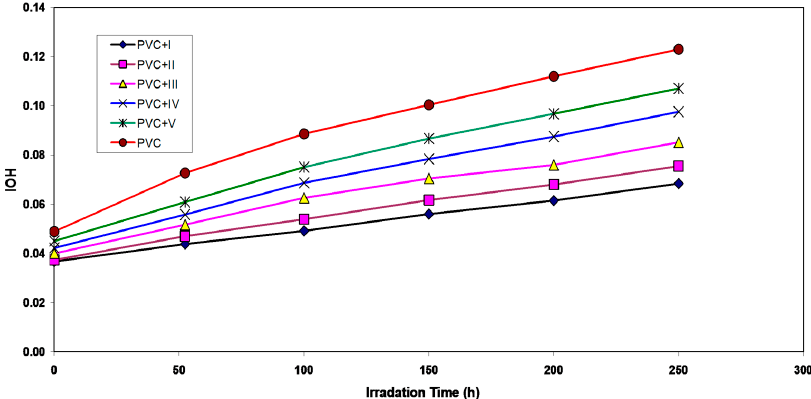
Figure 4. The relationship between the hydroxyl index and irradiation time for PVC films (30- μ m thickness) containing different additives. The concentration of additives is fixed at 0.5% by weight.